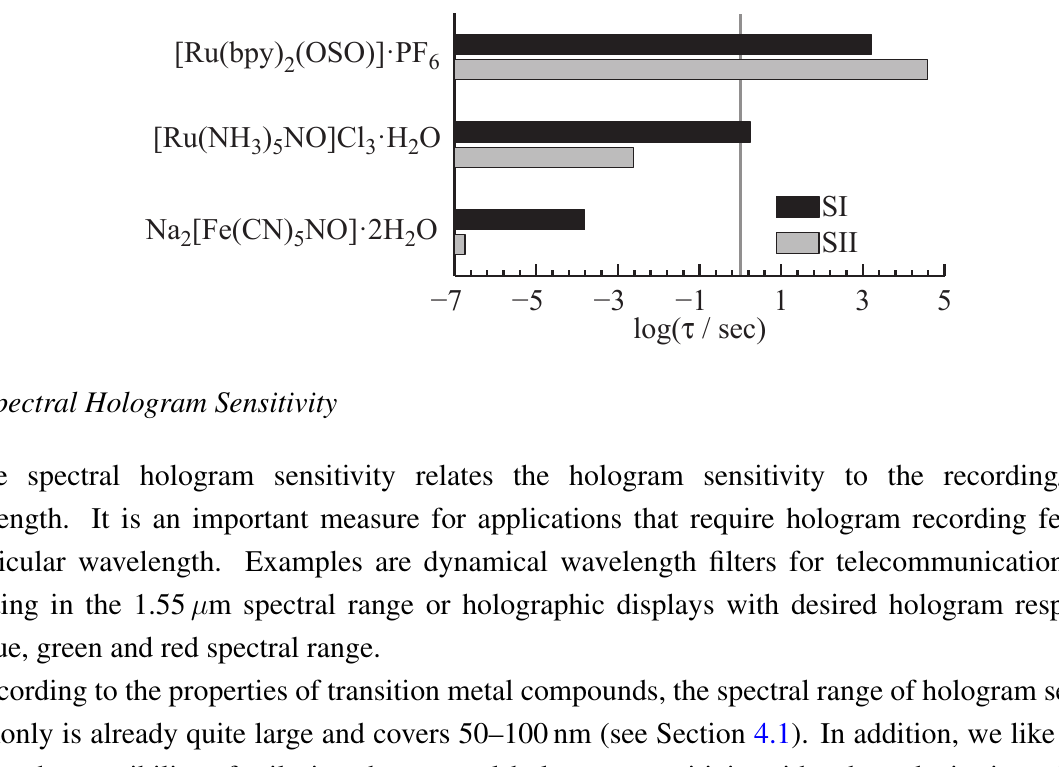
Figure 9. Lifetimes of the two metastable isomers for three exemplary compounds: A span from 1 . 1 × 10 − 7 s [33] to 3 . 5 × 10 4 s [20] can be covered by the choice of the sulfoxide or nitroprusside